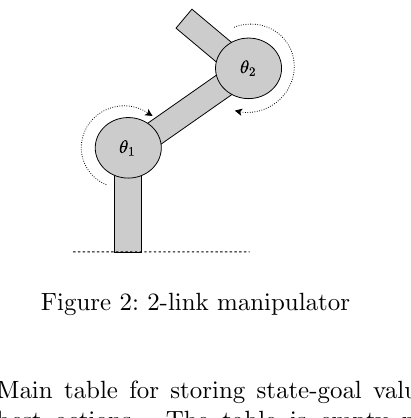
Table 1: Main table for storing state-goal values and best